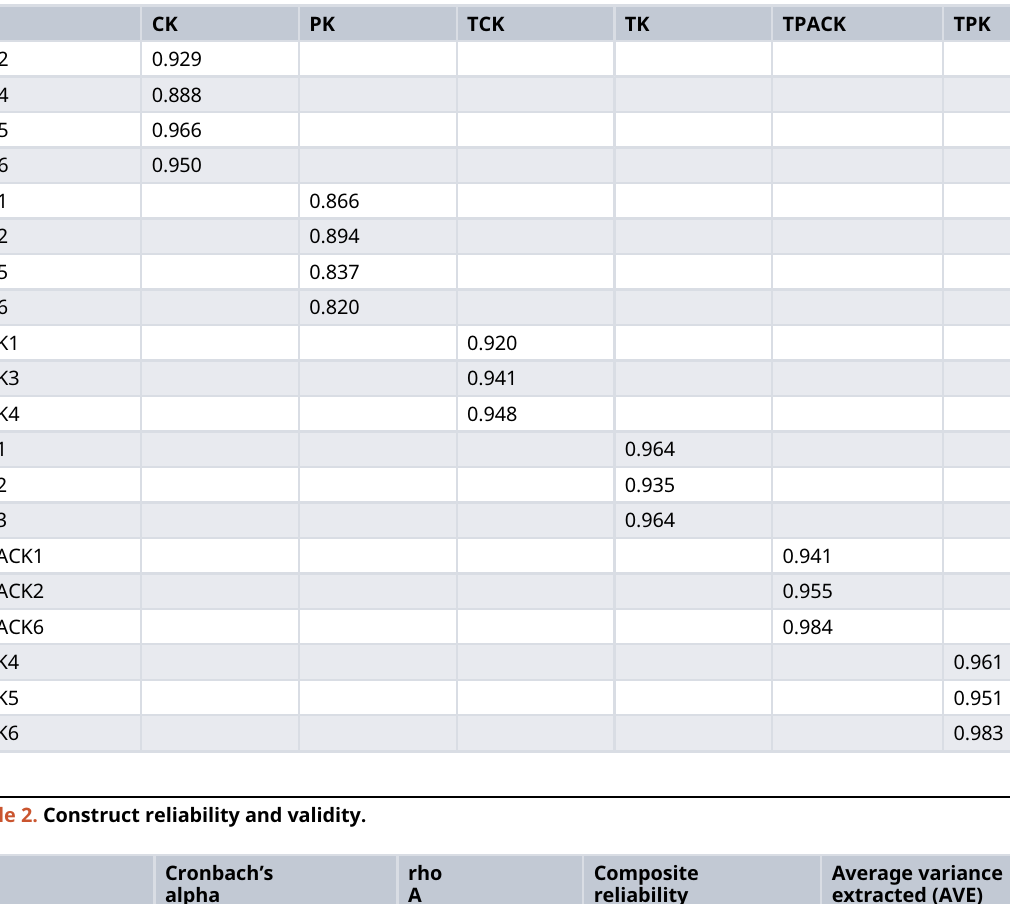
Table 1. Indicators of the constructs ’ outer